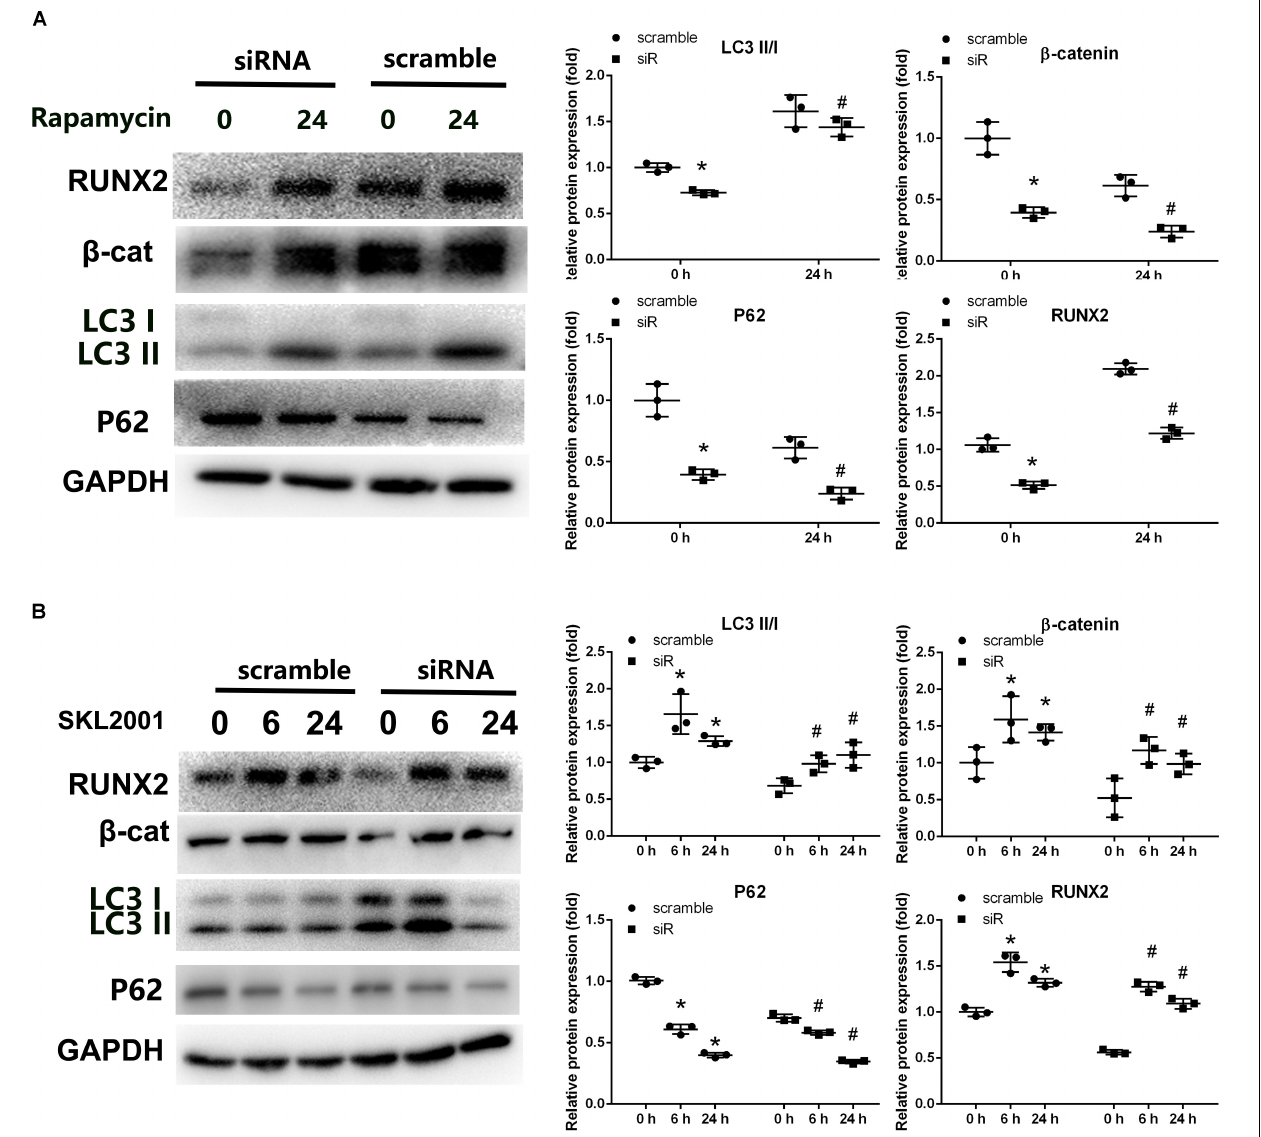
FIGURE 4 | Crosstalk between β -catenin signaling and autophagy in Parkin-downregulated BMSCs. (A) Expression levels of RUNX2, β -catenin, LC3, p62, and GAPDH were determined by WB analysis following rapamycin treatment (20 nM, 24 h). Protein expression levels were normalized to GAPDH. Data are expressed as the mean ± SD of three independent experiments, and one of three independent experiments is shown. * P < 0.05 vs. group with scramble siRNA. # P < 0.05 vs. group with Parkin small-interfering RNA. (B) Expression levels of RUNX2, β -catenin, LC3, p62, and GAPDH were determined by WB analysis following treatment with SKL2001 (20 µ M, 6 and 24 h). Protein levels were normalized to GAPDH. Data are expressed as the mean ± SD of three independent experiments, and one of three independent experiments is shown. * P < 0.05 vs. group with scramble siRNA. # P < 0.05 vs. group with Parkin